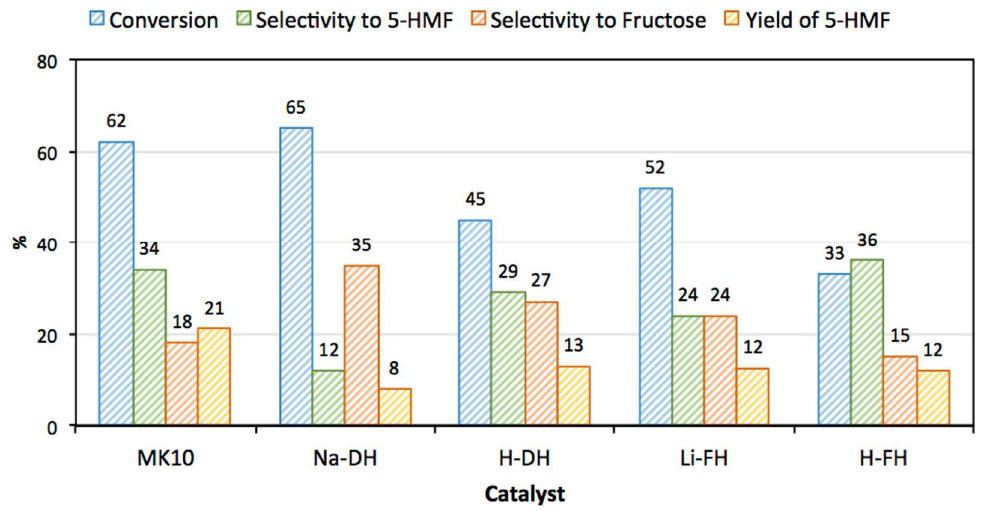
Figure 4. Catalytic activity of the commercial montmorillonite K10 and the synthesized and modified cationic clays. Reaction conditions: 2.4 g of glucose, 0.6 g of catalyst, catalyst/glucose wt ratio = 0.25, solvent volume ratio (THF:H 2 O) = 35:5, temperature = 140 °C and reaction time = 4 h.